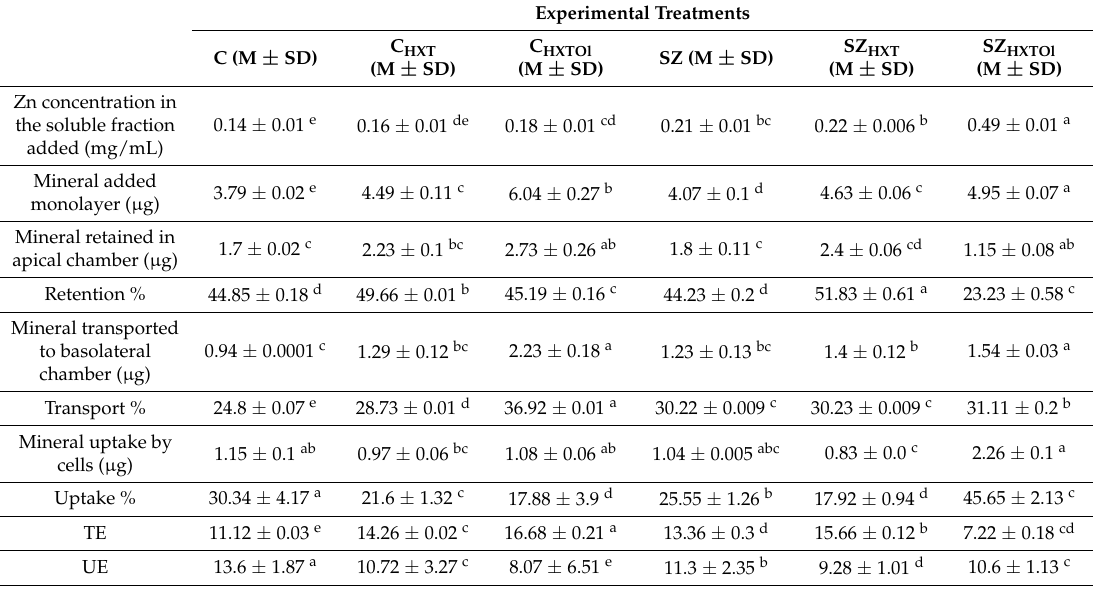
Table 6. Zn retention, transport, and cellular uptake in enriched